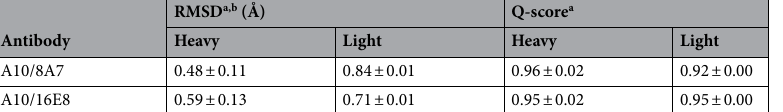
Table S2. In the RT-PCR procedure, Not I and Eco RI sites were added to the 5 ′ and 3 ′ end of the mA10 genes, respectively. The PCR products were then digested with Not I and Eco RI, and the heavy and light chain genes of mA10 were inserted into pQEFIP or pQEFIN vectors 16 , respectively. To construct the expression vectors of chimeric A10 antibody, the V H and V L genes of mA10 were com- bined with the heavy and light chain constant domain (C H , and C L , respectively) genes of 8A7, respectively. The constructed mA10 plasmids were used to amply the V H and V L genes of mA10. Previously constructed 8A7 plasmids 16 were used to amplify the C H and C L genes because 8A7 has typical sequences of C H and C L for immu-